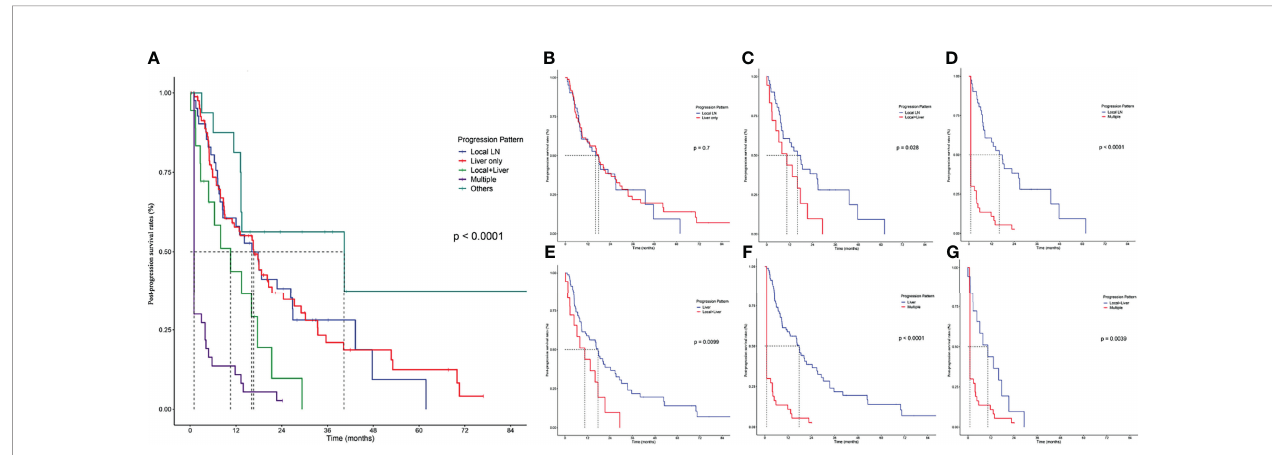
FIGURE 1 | Pairwise comparison of post-progression survival in patients with different progression patterns. (A) PPS strati fi ed by all progression patterns. Strati fi cation of patients by comparing the following progression patterns: (B) Local LN vs. Liver only; (C) local LN vs. Local+Liver; (D) local LN vs. Multiple; (E) Liver vs. Local+Liver; (F) Liver vs. Multiple; (G) , Local+Liver vs.